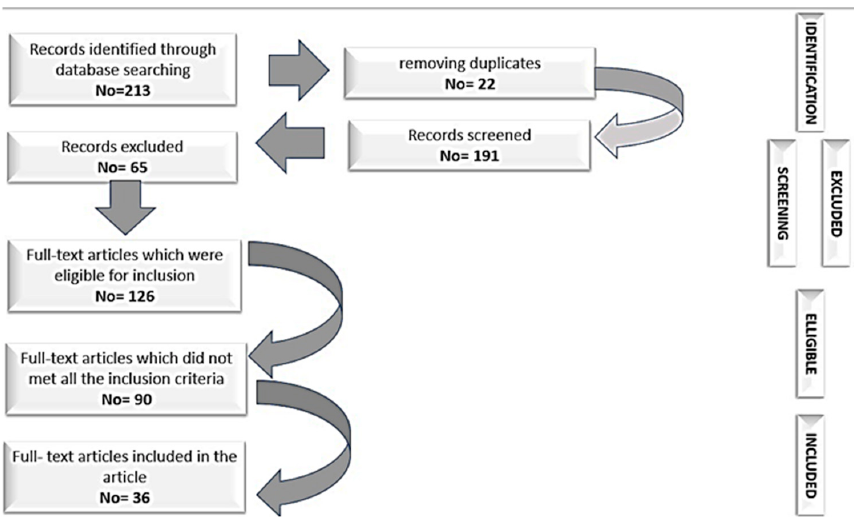
Figure 1. The selection process.